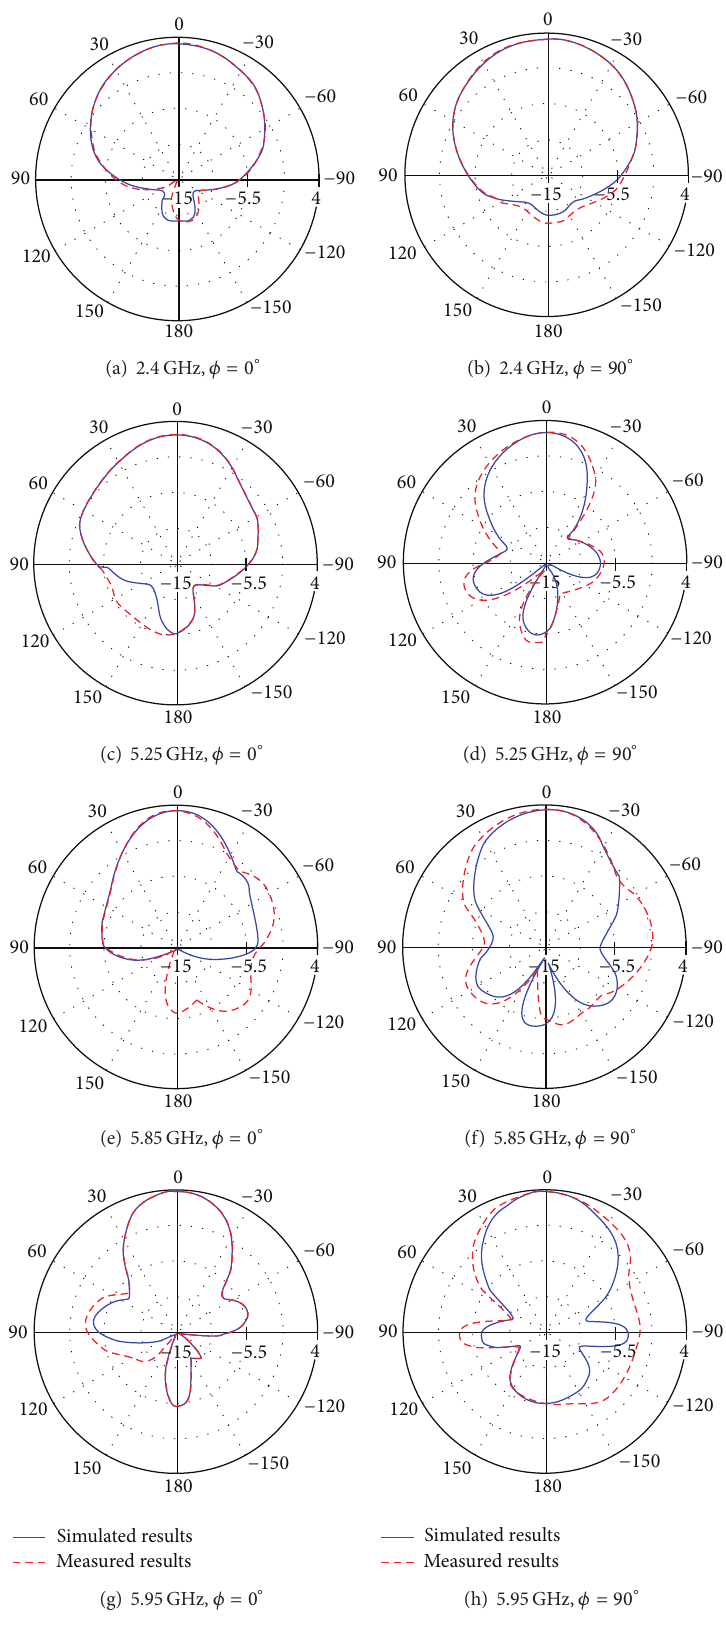
Figure 8: Gain patterns at different resonant frequencies in both E- and